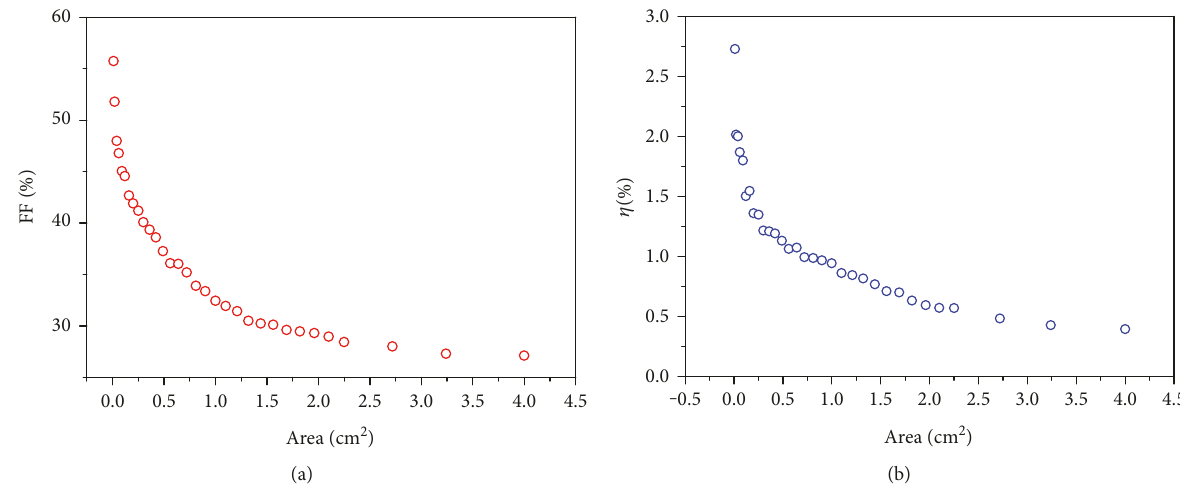
Figure 4: (a) Fill factor decay as active area increases. (b) Device e ffi ciency decay towards a higher active